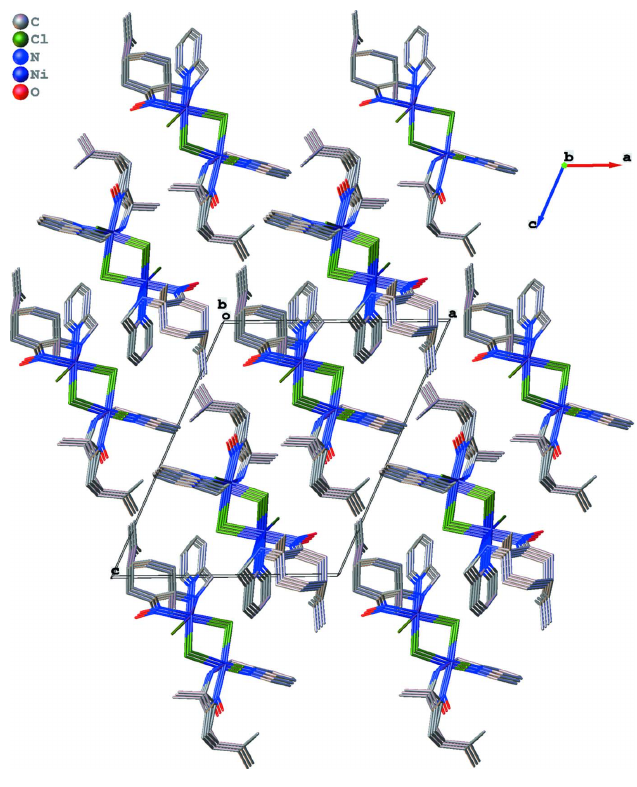
Figure 3 Packing diagram.